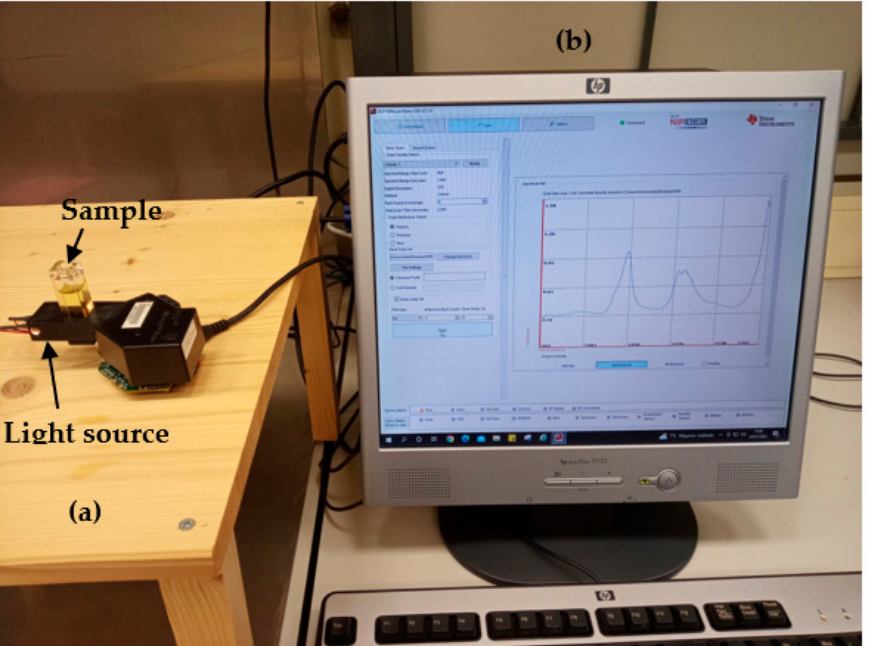
Figure 2. Transmittance measurement setup: ( a ) DLP NIRscan Nano EVM, ( b ) Graphical User Interface (GUI). Section 3.4 describes the GUI.